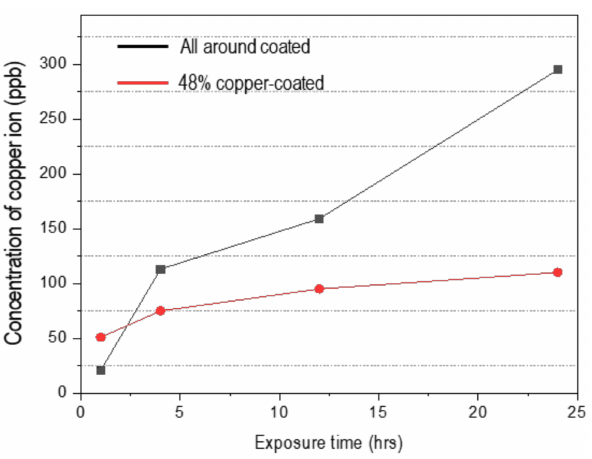
Figure 8. The variation in copper ion release from all-around and 48%-copper-coated in un-inoculated Luria broth medium vs. exposure